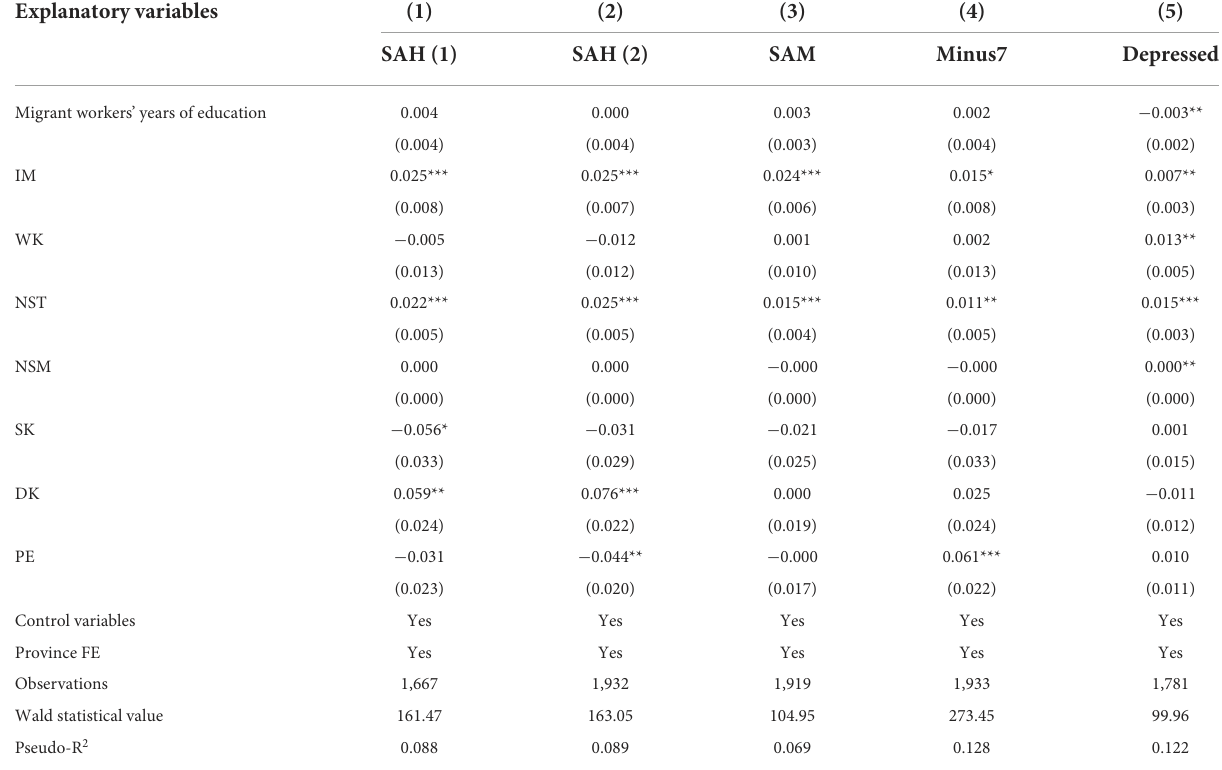
TABLE 9 Mechanism analysis: third